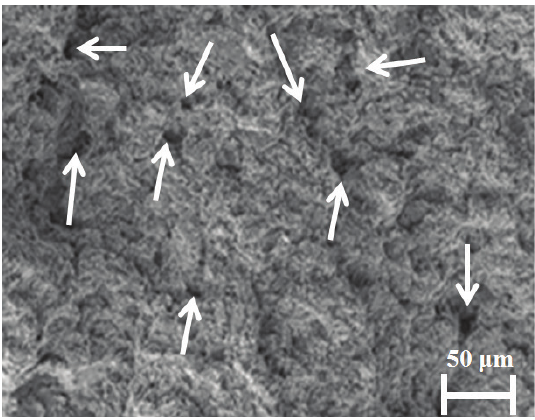
Figure 5: Comparison of flexural strengths of unreinforced AlSi alloy and the composite samples with micro and nano-sized Al particles.